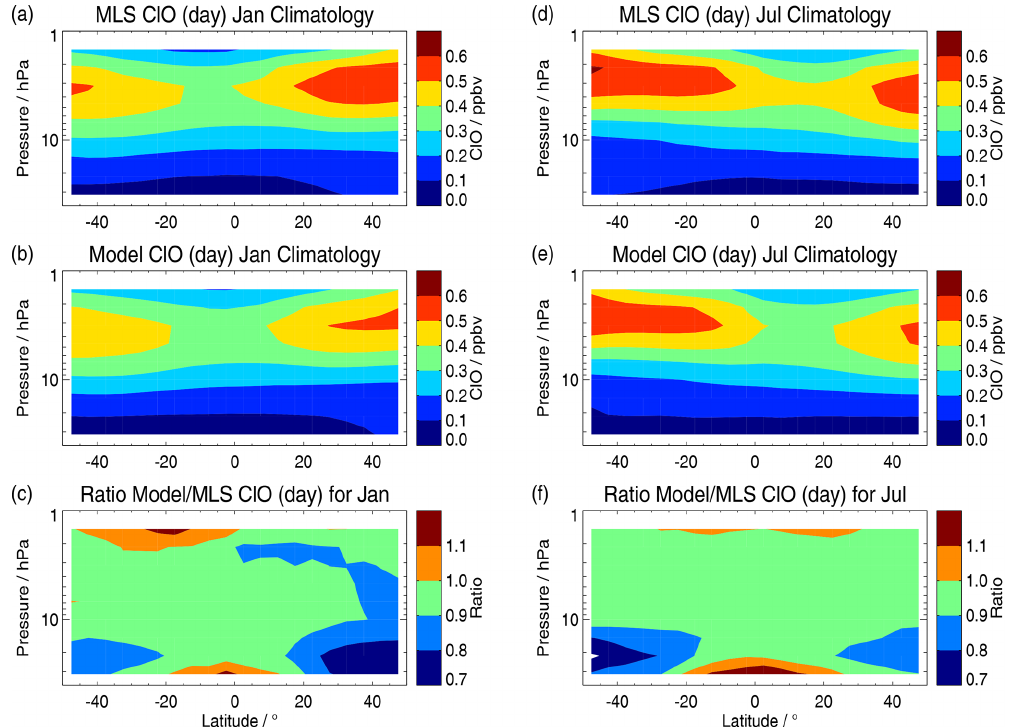
Figure 1. Climatological mean fields (over 2005 through 2020) for ClO (daytime data) from MLS and model results between 50 ◦ S and 50 ◦ N and 32 to 1.5hPa. Daytime averages (observed and simulated values) are based on values with solar zenith angles less than 90 ◦ only. Panels (a) and (b) show the January MLS and model climatologies, respectively, while panel (c) gives the ratio (model values divided by MLS values) for that month; panels (d) , (e) , and (f) are the same as (a) , (b) , and (c) , respectively, but for July instead of January. The model daily values (throughout this work) were sampled to provide the closest match in space and time to the MLS daily level-2 data; model results were then binned in latitude and averaged over each month (and interpolated to the MLS pressure grid), in order to best match the averaging process of MLS monthly zonal mean